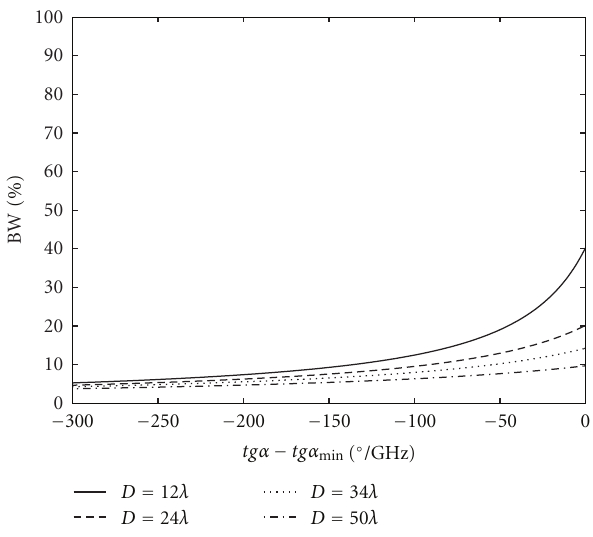
Figure 3: Percent bandwidth versus element phase curve slope for di ff erent array diameters ( F/D = 1).